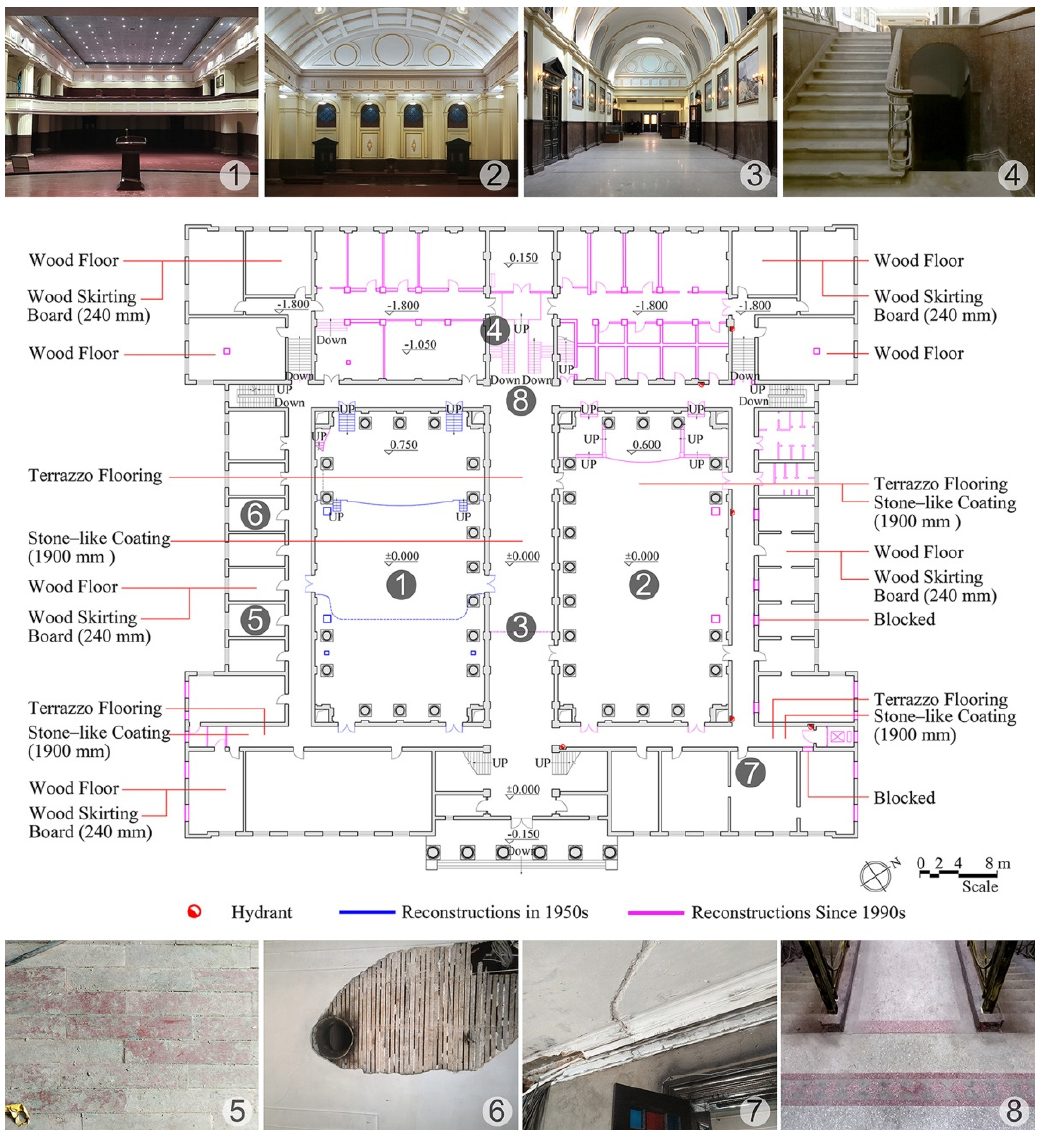
Figure 9. Ground Floor Plan of Qingdao Exchange Building.